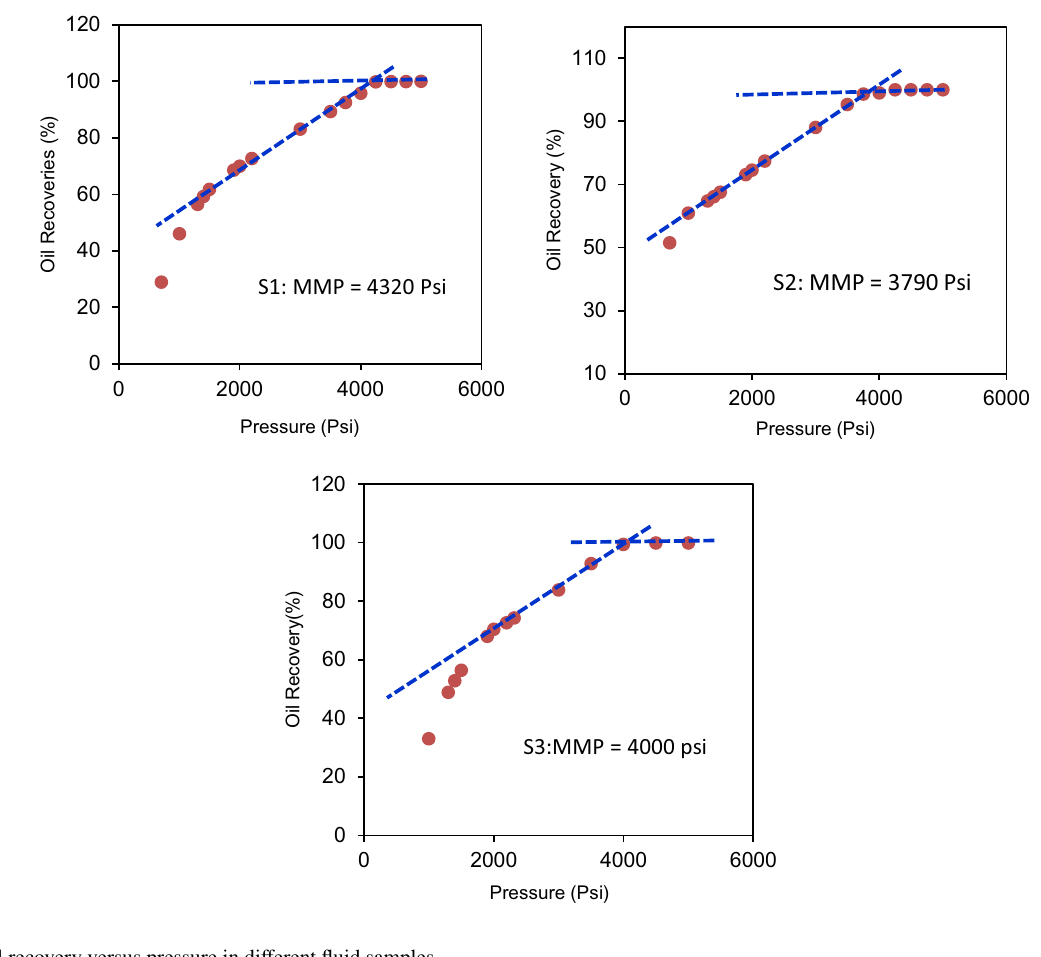
Fig. 6 Oil recovery versus pressure in different fluid samples